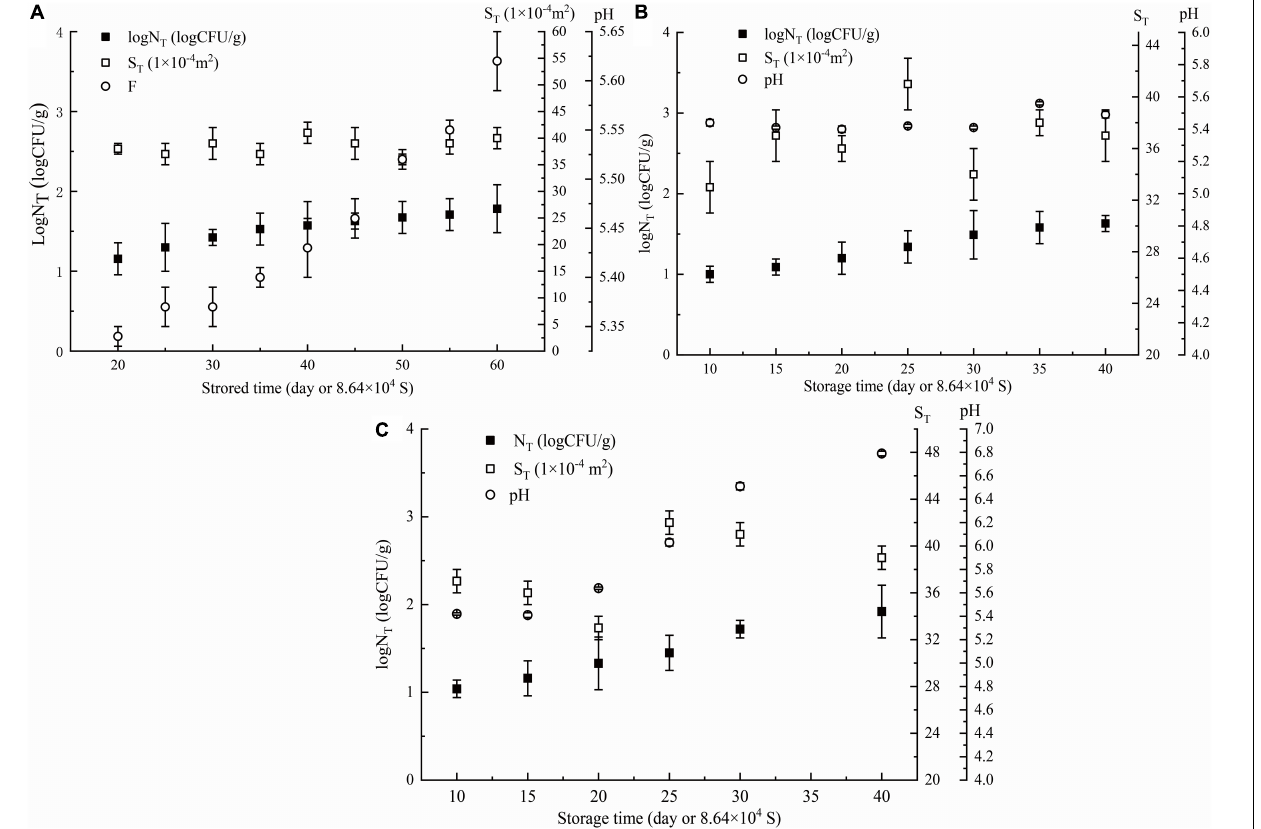
N T / N 0 was correlated by a power function with the He, pH T , and a wT